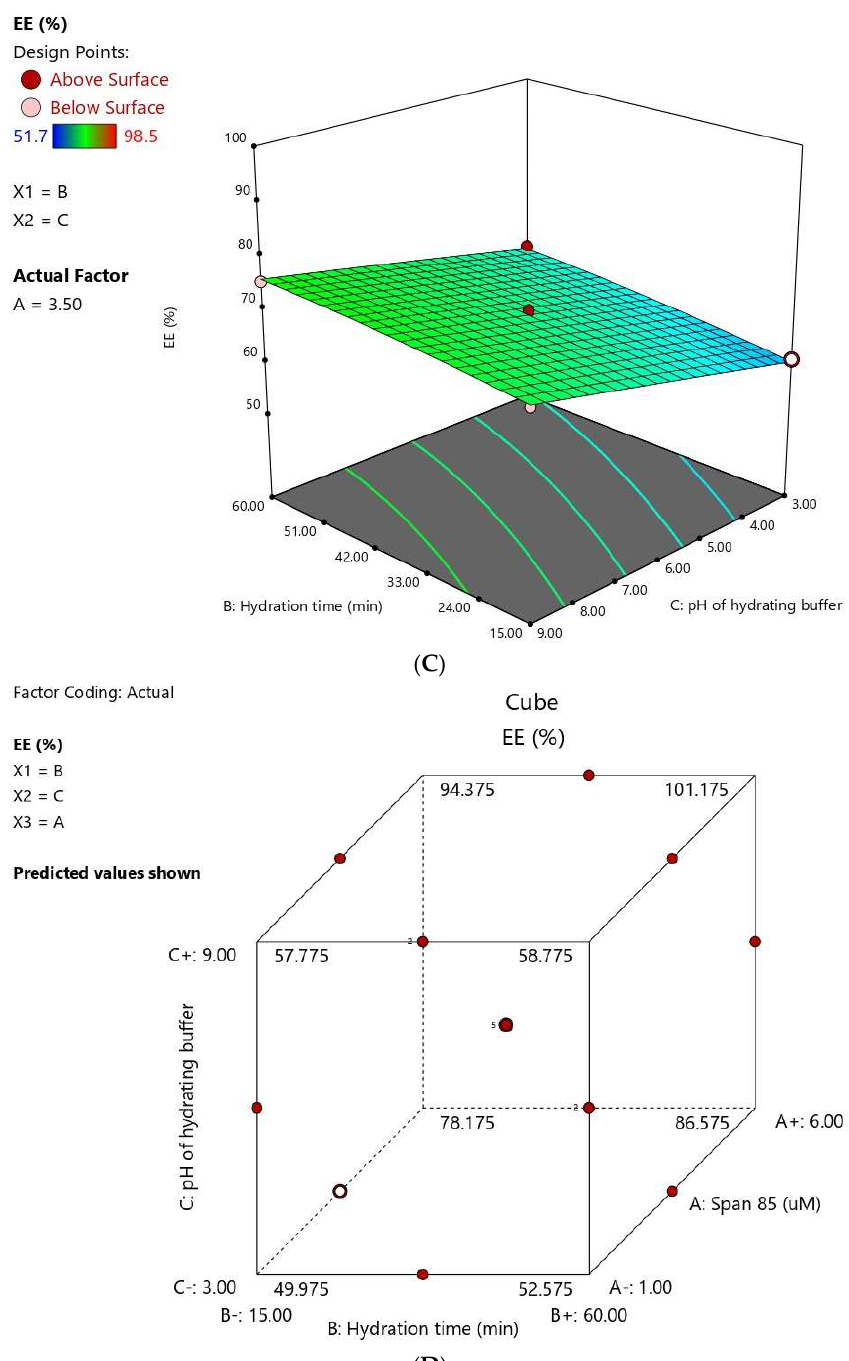
Figure 4. Response 3D plots ( A , B , and C ) and cube plot ( D ) for the effect of Span ® 85 concentration (X 1 ), hydration time (X 2 ), and hydrating buffer pH (X 3 ) on the entrapment efficiency of FLB niosomes.